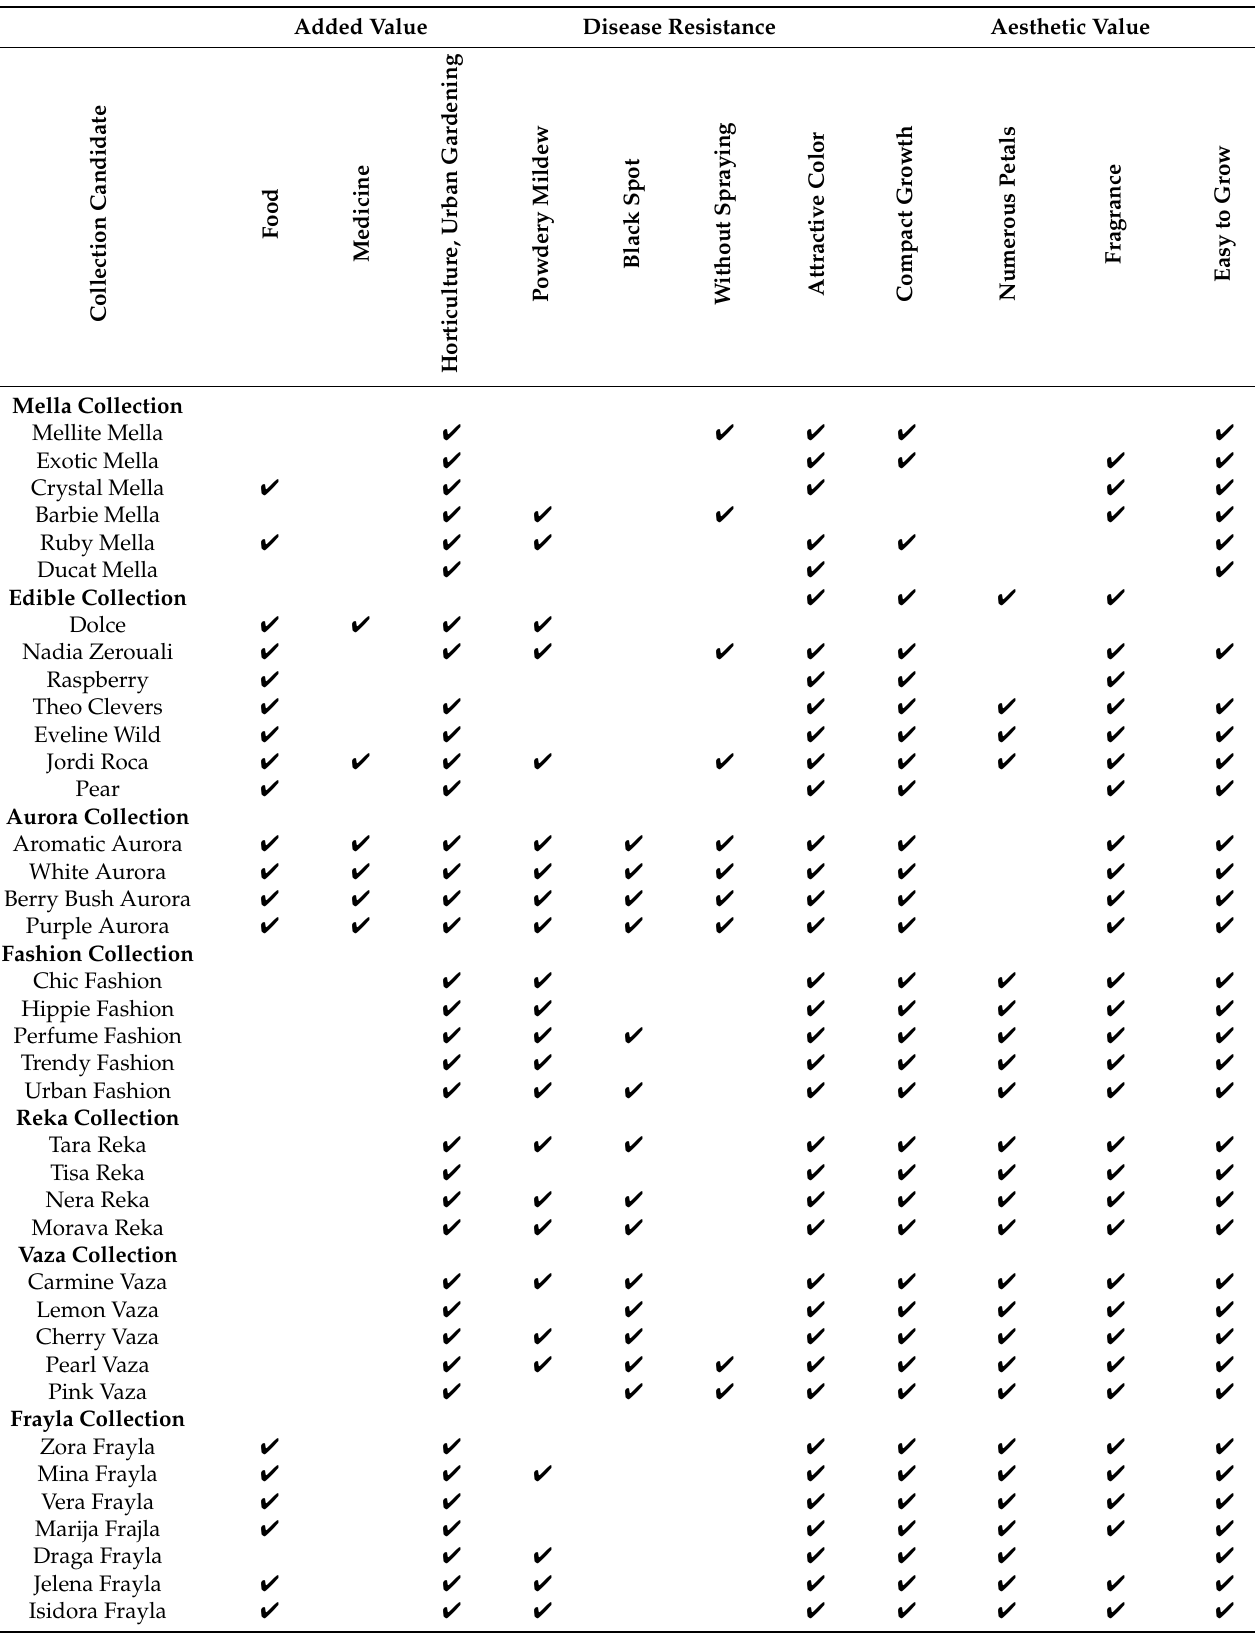
Table 1. Garden rose breeding in Serbia to meet sustainable development goals. Added Value Disease Resistance Aesthetic